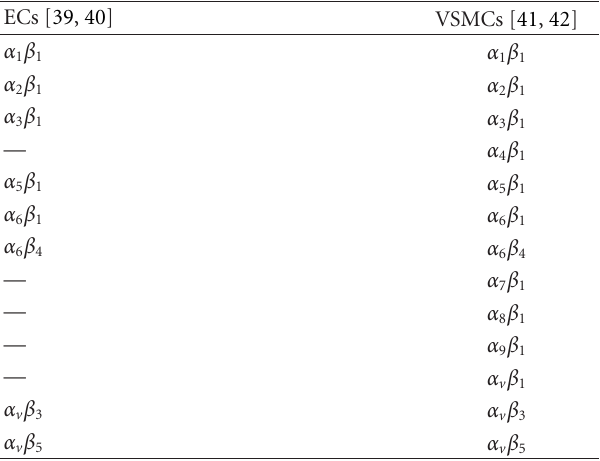
Table 2: Integrins expressed in ECs and